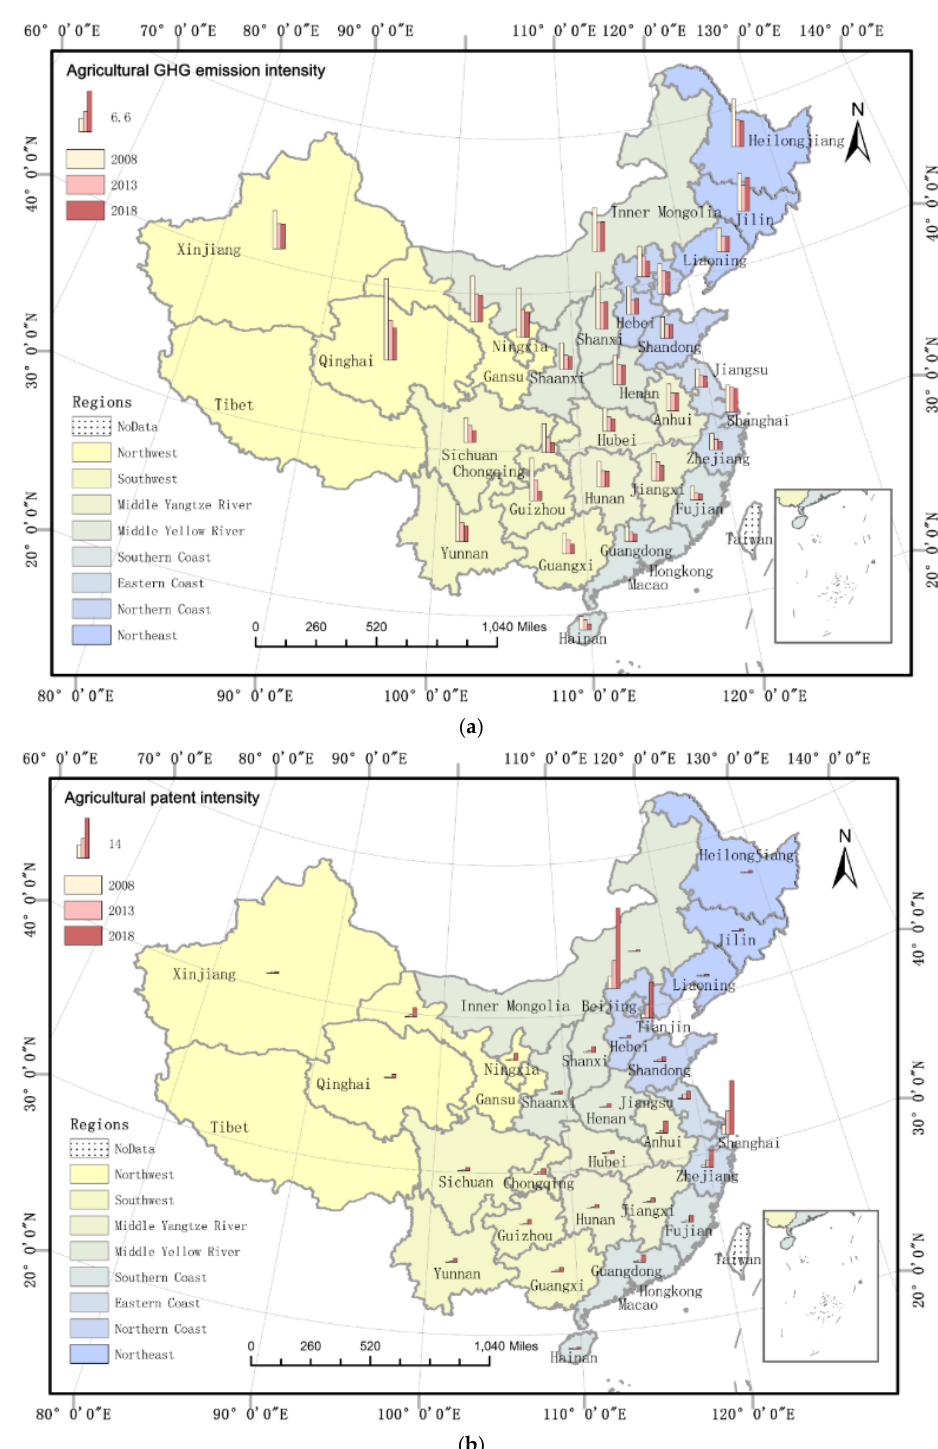
Figure 4. Spatial pattern of agricultural carbon emission ( a ) and patent intensity ( b ). Figure 4b shows the regional differences in agricultural technology innovation levels were expanding. The technological innovation level of Beijing and Tianjin on the north- ern coast and Shanghai on the eastern coast was considerably higher than that of other provinces. The technological innovation exhibited a decreasing trend from south to north and from east to west. The level of agricultural technology innovation gradually improved in all